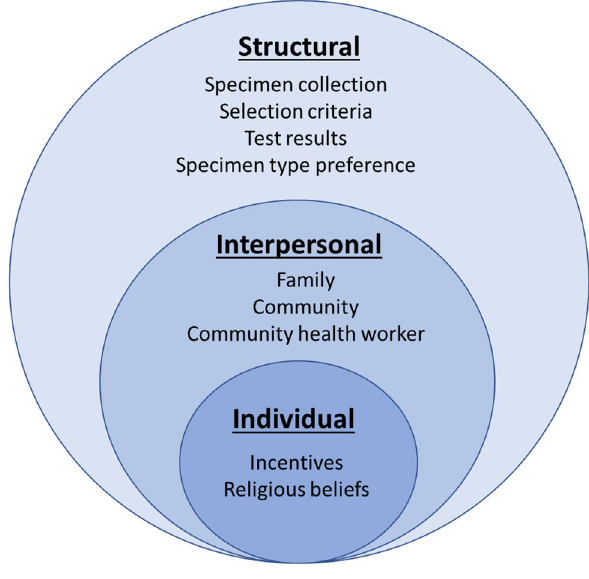
Table 3 Individual influences: barriers & facilitators to serosurvey participation according to